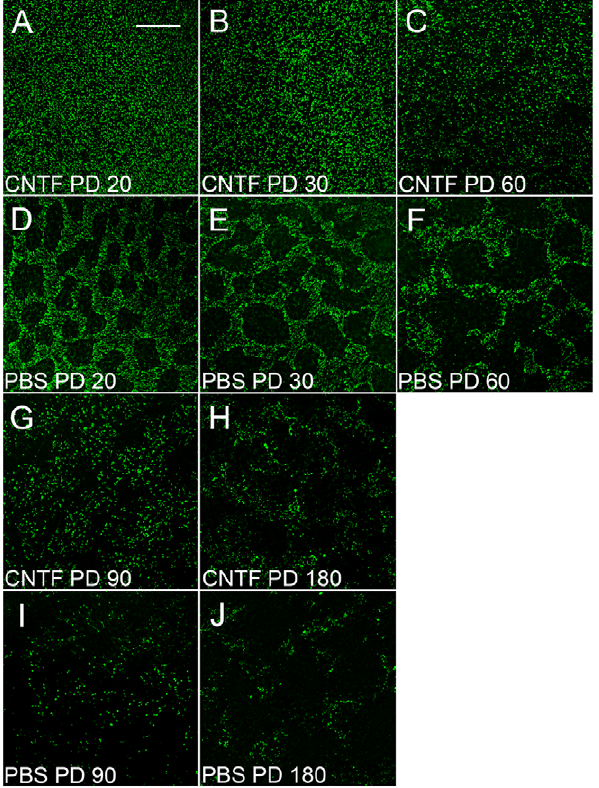
Figure 6. Increase in PNA-positive cells after CNTF treatment. Retinas (superior regions) of PD 10, 20, 50, 80, and 170 S334ter-3 rats were treated with either CNTF (left eyes) or PBS (right eyes) and collected 10 days after treatment. Whole-mounted retinas of PD 20 (i.e., injected at PD 10; A, CNTF; D, PBS), PD 30 (B, CNTF; E, PBS), PD 60 (C, CNTF; F, PBS), PD 90 (G, CNTF; I, PBS), and PD 180 (H, CNTF; J, PBS), were stained with PNA. Many PNA-negative areas appeared in PBS treated retinas, whereas no PNA-negative areas were seen in the PD 20 retinas treated with CNTF (A). The PNA-negative areas became much smaller and in most cases completely disappeared in PD 30 and 60 retinas treated with CNTF (B and C). Increase in PNA positive cells after CNTF treatment became less dramatic in PD 60 retinas (G), and by PD 180 (H), little or no significant increase is observed. Scale bar: 200 m m.